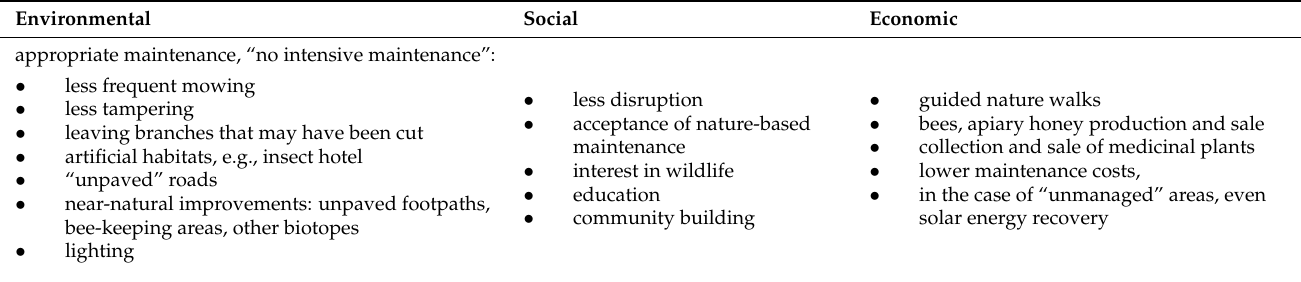
Table 4. Environmental, social and economic benefits of green solutions (authors’